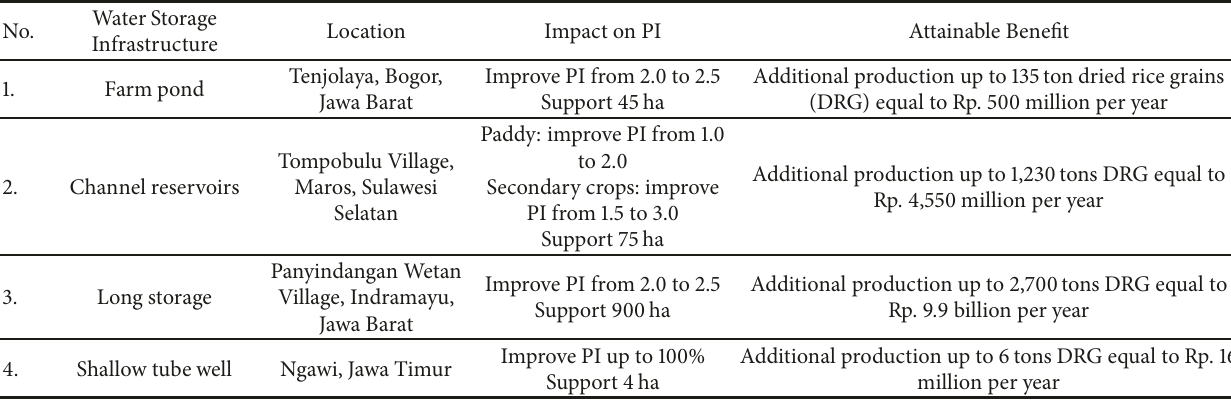
Table 1: Comparison of yield from annual cropping pattern in rain-fed